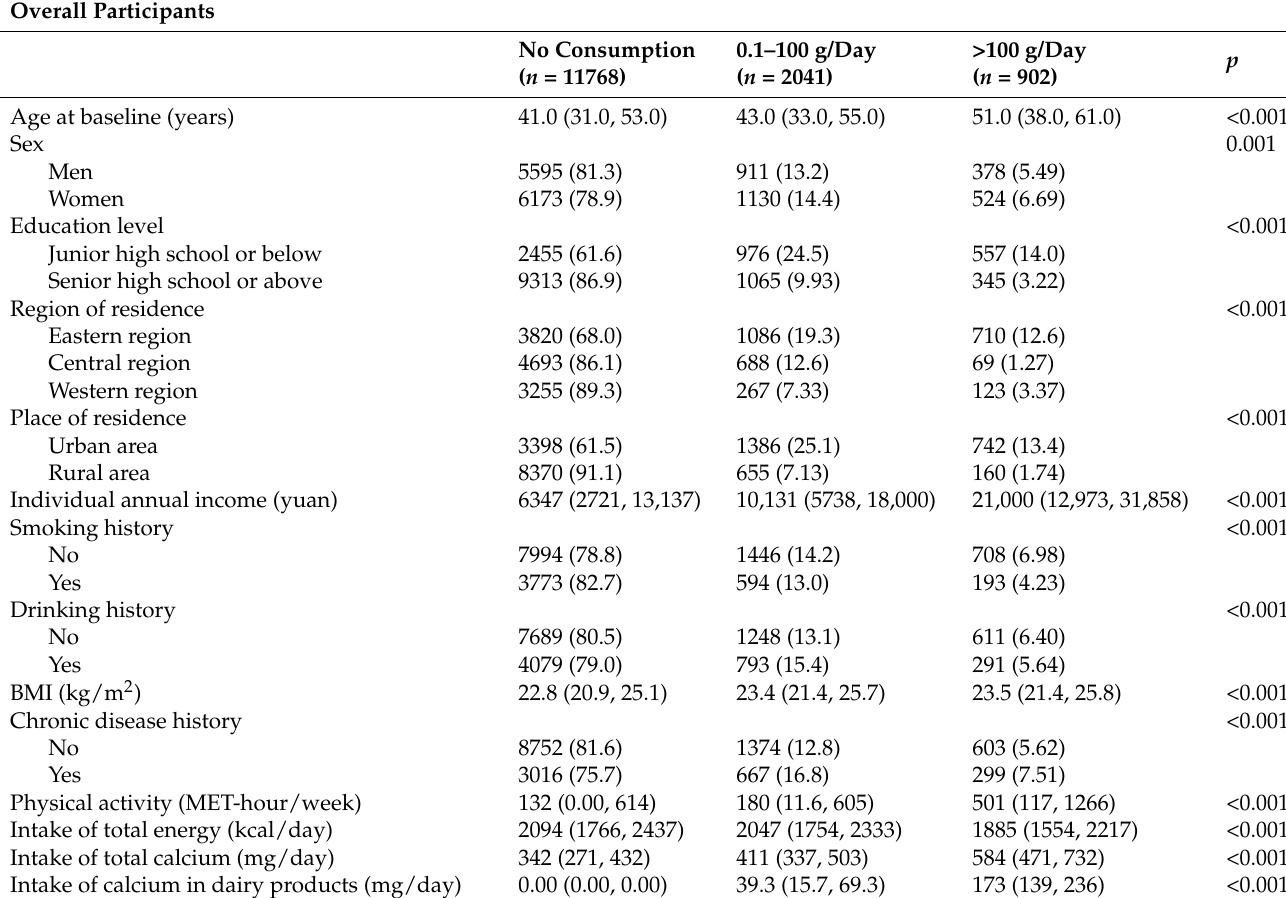
Table 1. Basic demographic, lifestyle, and dietary intake characteristics across dairy product intake groups in overall, male, and female